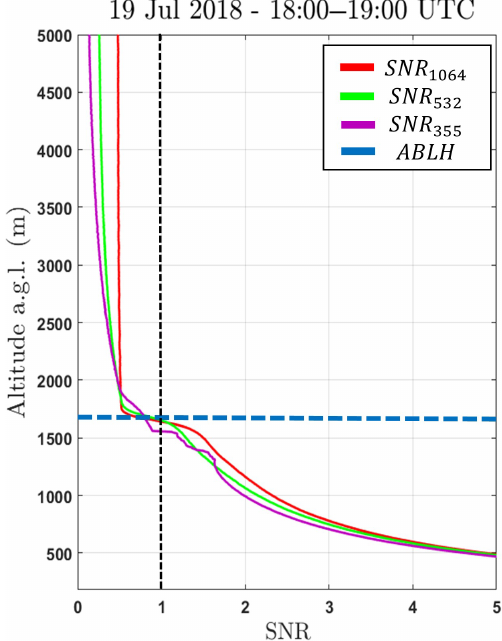
Figure 10. Signal-to-noise-ratio (SNR) profile of the three wave- lengths (1064nm; red line, 532nm green line; and 355nm, violet line) obtained on 19 July 2018 between 18:00 and